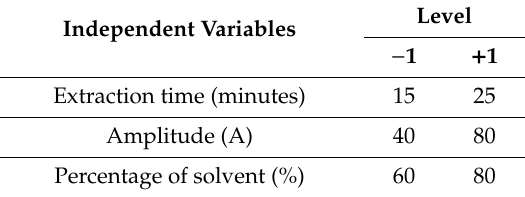
Table 9. Level of extraction